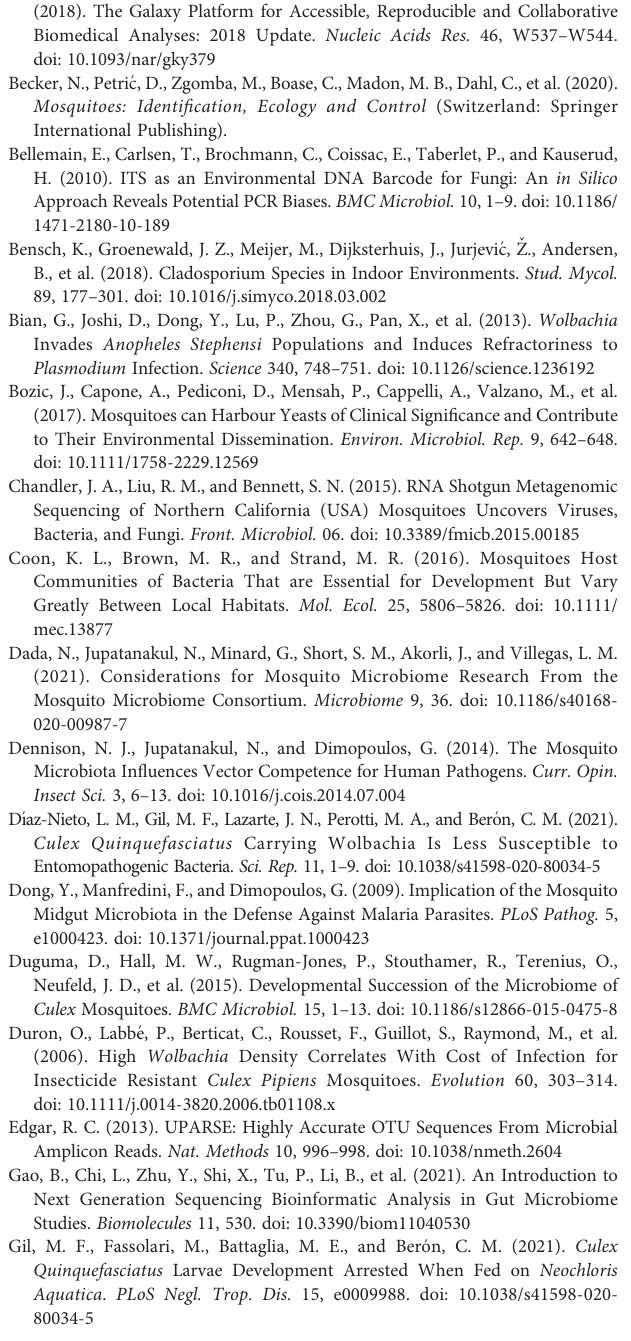
(OTUs, with 97% sequence similarity cut-off value) is plotted against the number of reads sampled. Supplementary Data Sheet 1 | Krona plots of Cx. quinquefasciatus fungal holobiont identi fi ed in each development instar. L, larvae; M, sucrose-fed male; SF, sucrose-fed females; BF, blood-fed females. The results are illustrated in an